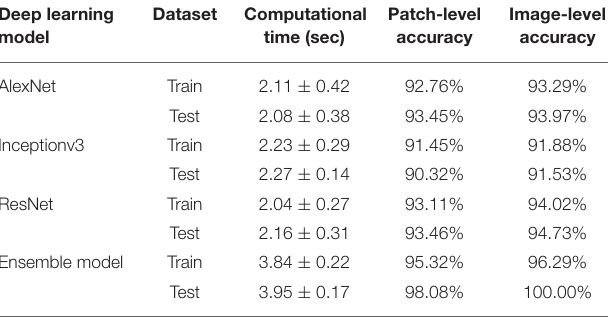
TABLE 4 | Performance of the proposed algorithm in mast cell tumors grading. Deep learning Dataset Computational Patch-level Image-level model time (sec) accuracy